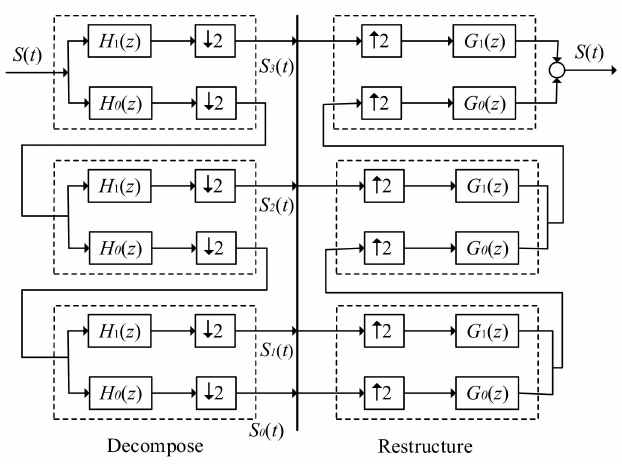
Figure 4. Haar wavelet decomposition and reconstruction